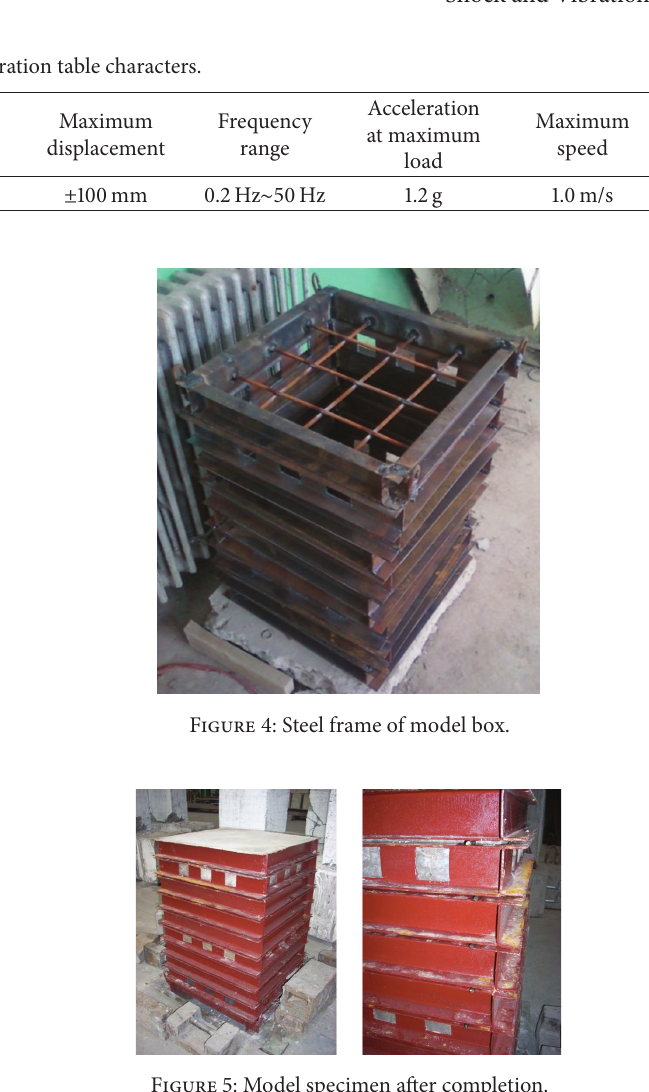
Figure 5: Model specimen after completion.